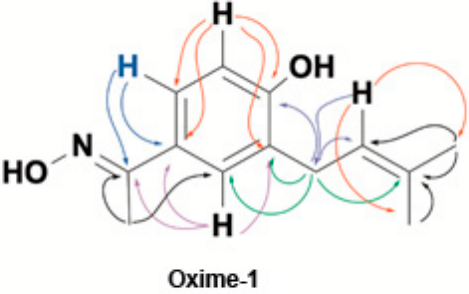
Figure 2. Selected HMBC correlations for 4-hydroxy-3-(isopenten-2-yl)-acetophenoxime (Oxime–1).